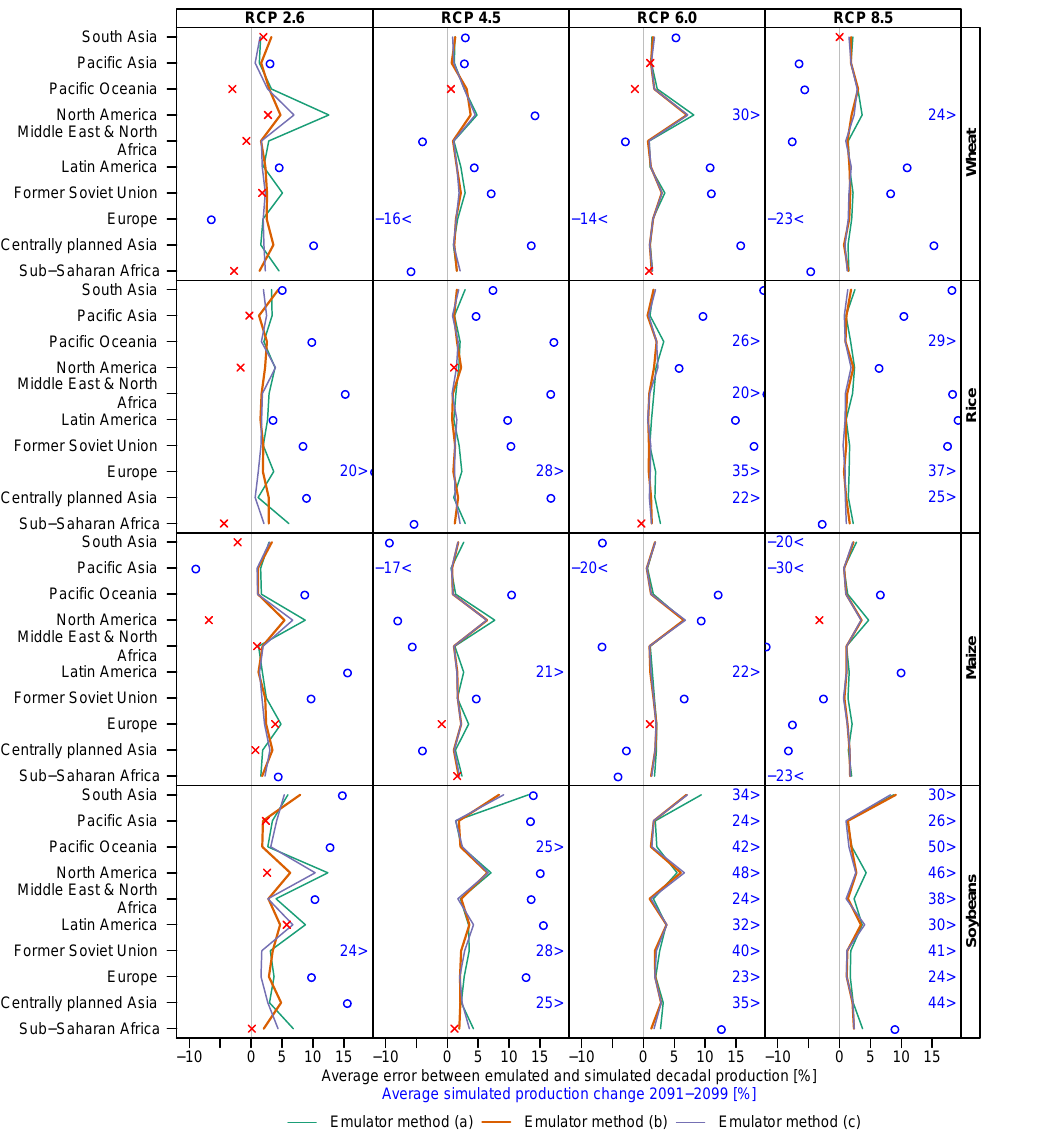
exist, e.g. in North America, which also stands out in Figs.